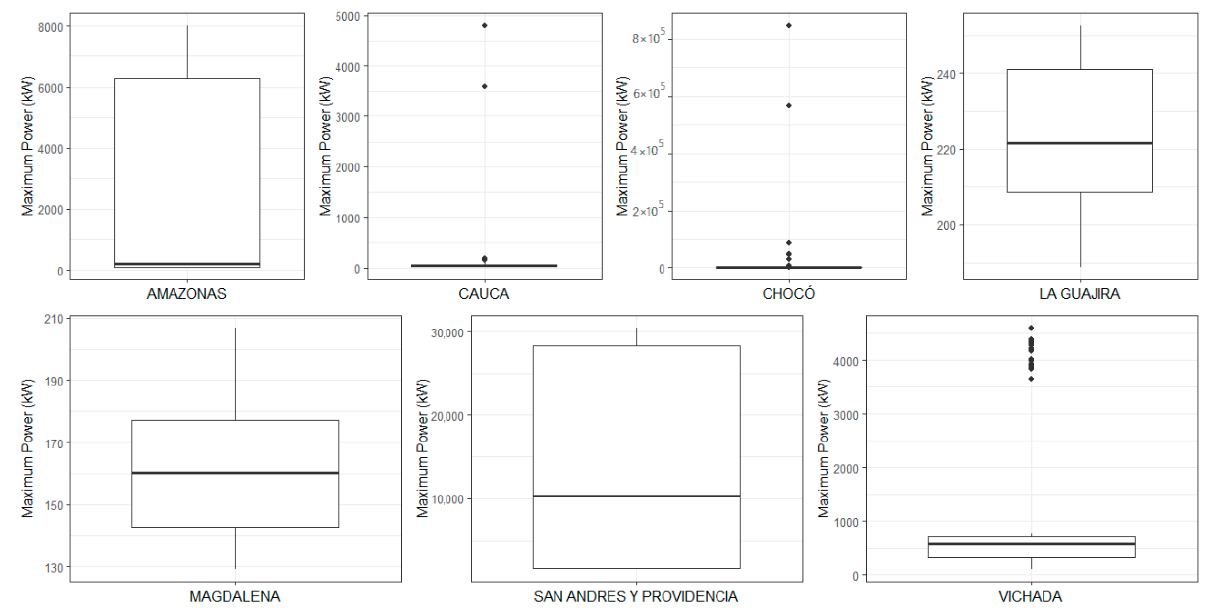
Figure 2. Box and Whisker: Maximum Power for shire county.